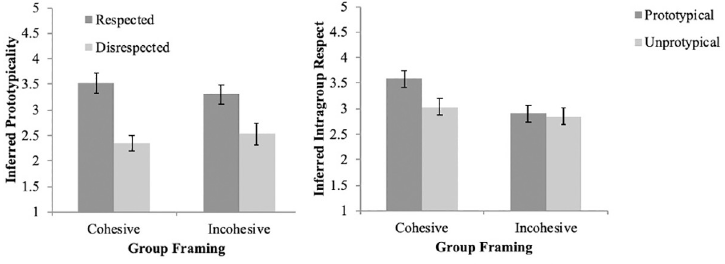
Fig 3. Inferred intragroup respect and inferred prototypicality as a function of target prototypicality or target intragroup respect.